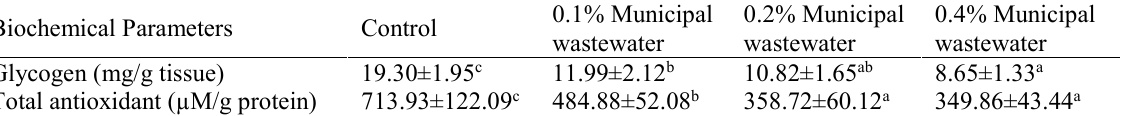
Table 3. Biochemical parameters in entire body of galba truncatula exposed to 0.1%, 0.2%, and 0.4% of municipal wastewater for 14